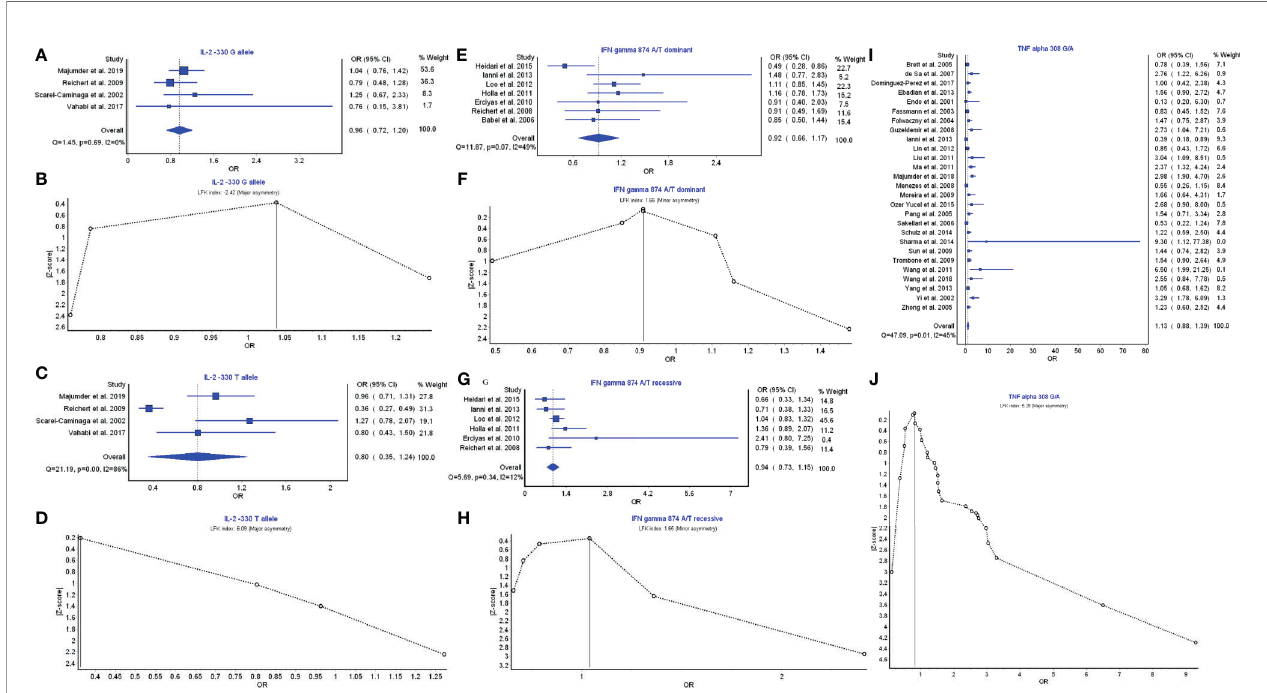
FIGURE 2 | The association of Th1-related cytokine polymorphism with chronic periodontitis. (A) Forest plot of the association of IL ‐ 2 − 330 G allele polymorphism with chronic periodontitis. (B) The Doi plot is used to visualize the asymmetry of the association of IL ‐ 2 − 330 G allele polymorphism with chronic periodontitis using the LFK index. LFK index zero represents complete symmetry, the limits of symmetry were set at ±1, and values beyond ±1 were inconsistent with symmetry. (C) Forest plot of the association of IL ‐ 2 − 330 T allele polymorphism with chronic periodontitis. (D) The Doi plot is used to visualize the asymmetry of the association of IL ‐ 2 − 330 T allele polymorphism with chronic periodontitis using the LFK index. (E) Forest plot of the association of IFN- g 874 A/T dominant polymorphism with chronic periodontitis. (F) The Doi plot is used to visualize the asymmetry of the association of IFN- g 874 A/T dominant polymorphism with chronic periodontitis using the LFK index. LFK index zero represents complete symmetry, the limits of symmetry were set at ±1, and values beyond ±1 were inconsistent with symmetry. (G) Forest plot of the association of IFN- g 874 A/T recessive polymorphism with chronic periodontitis. (H) The Doi plot is used to visualize the asymmetry of the association of IFN- g 874 A/T recessive polymorphism with chronic periodontitis using the LFK index. (I) Forest plot of the association of TNF- a 308 G/A polymorphism with chronic periodontitis. (J) The Doi plot is used to visualize the asymmetry of the association of TNF- a 308 G/A polymorphism with chronic periodontitis using the LFK index. LFK index zero represents complete symmetry, the limits of symmetry were set at ±1, and values beyond ±1 were inconsistent with